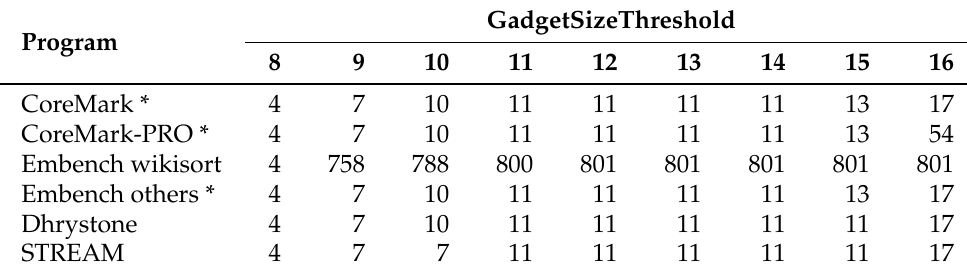
Table 4. Maximum value of GadgetCounter observed with different values of GadgetSizeThreshold con- figured in detection logic, during the non-attack-related benchmark’s execution. Sets of benchmarks are noted with a